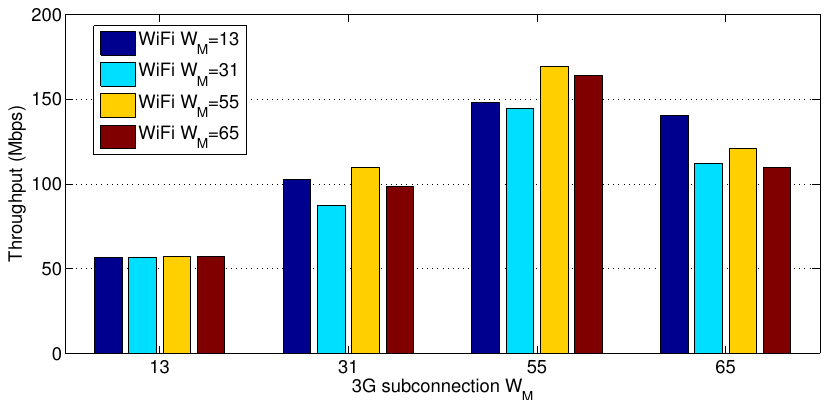
Figure 4. Throughput comparison at 3G speed 70 Mbps.